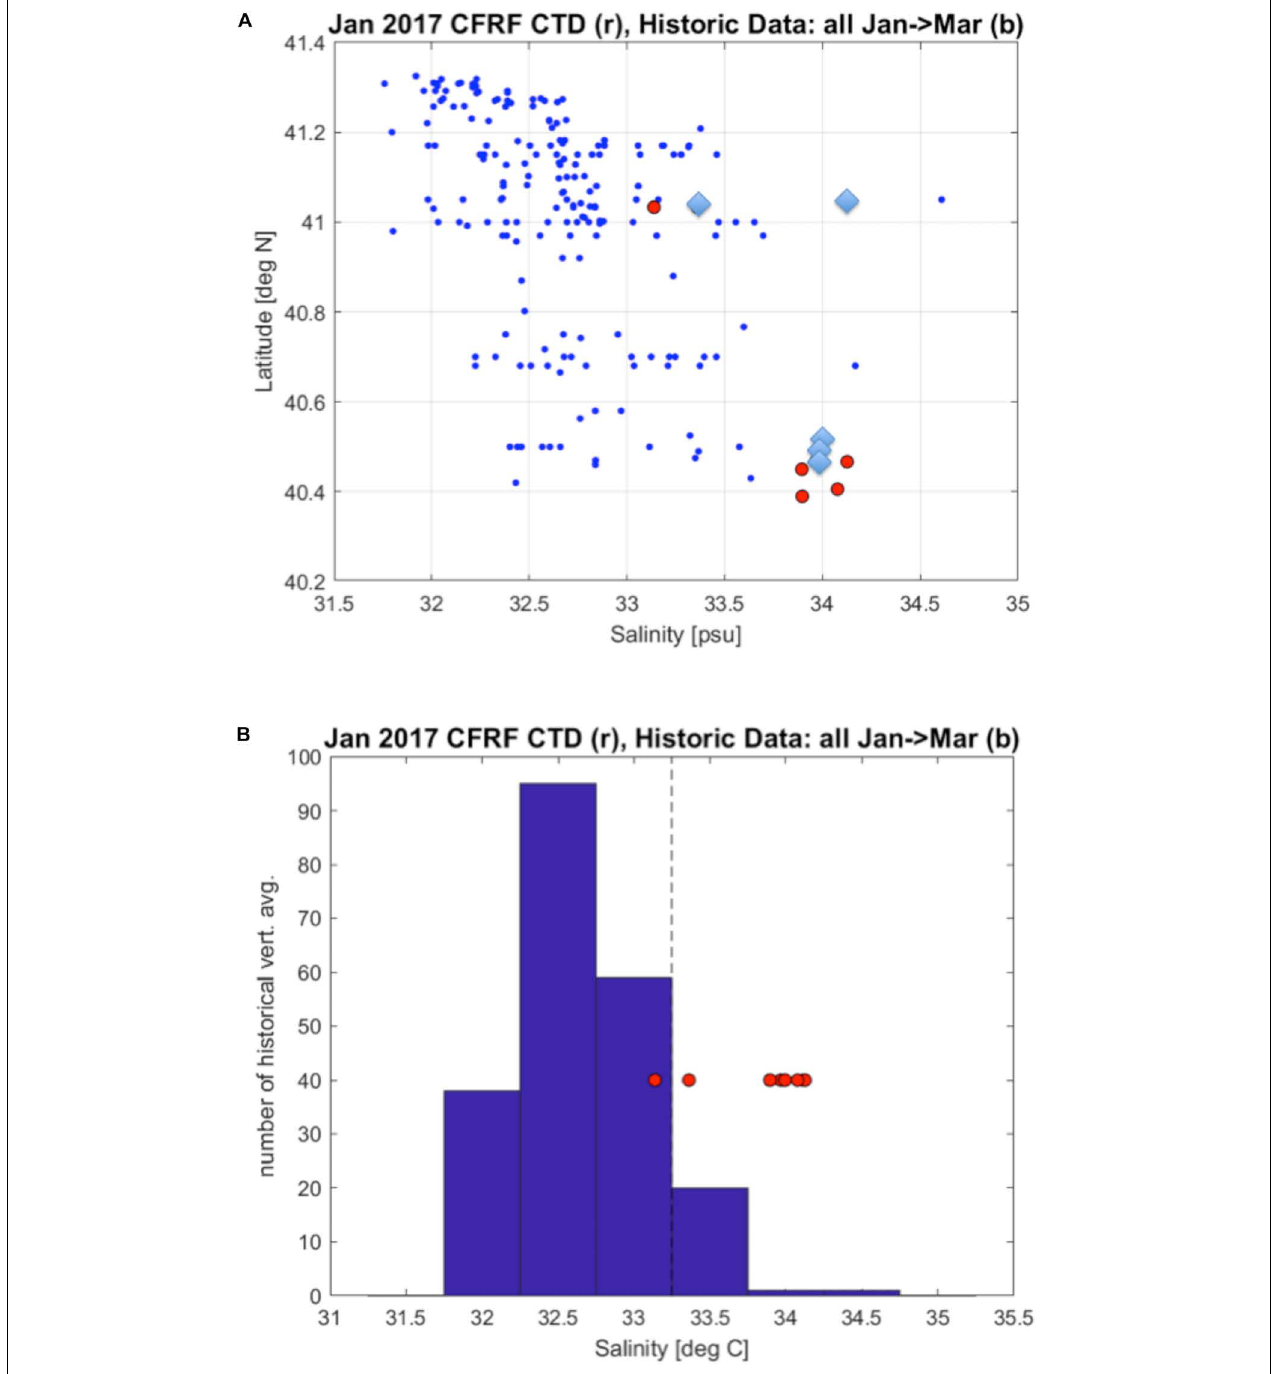
FIGURE 4 | Same as in Figure 3 but with depth-averaged